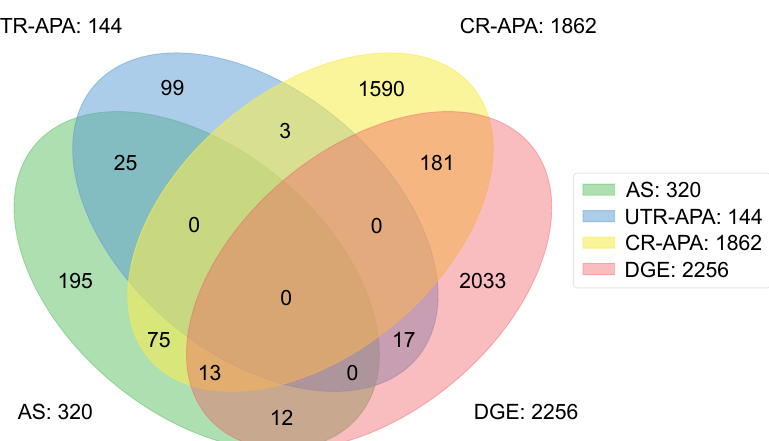
Figure 9. Four-set Venn diagram shows the overlapped genes in three different types of post- transcriptional regulations and differentially expressed genes